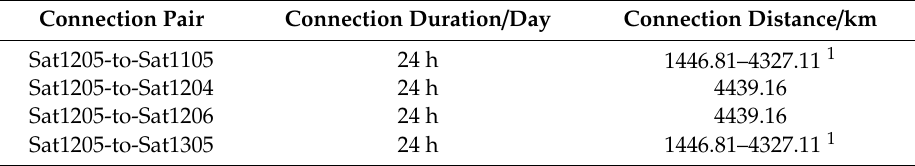
Table 1. Connection duration and connection distance between satellite and satellite.